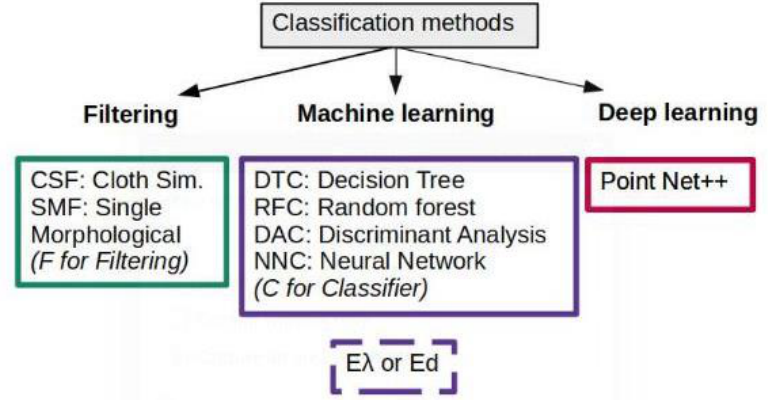
Figure 1. Summary of the methods tested in this